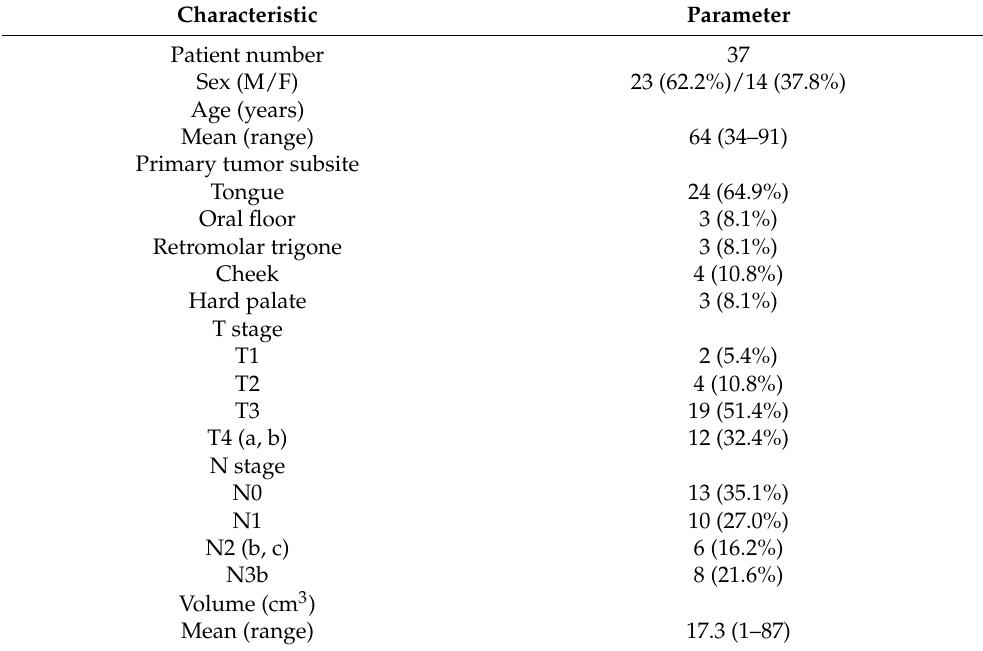
Table 1. Selected patient and tumor characteristics.